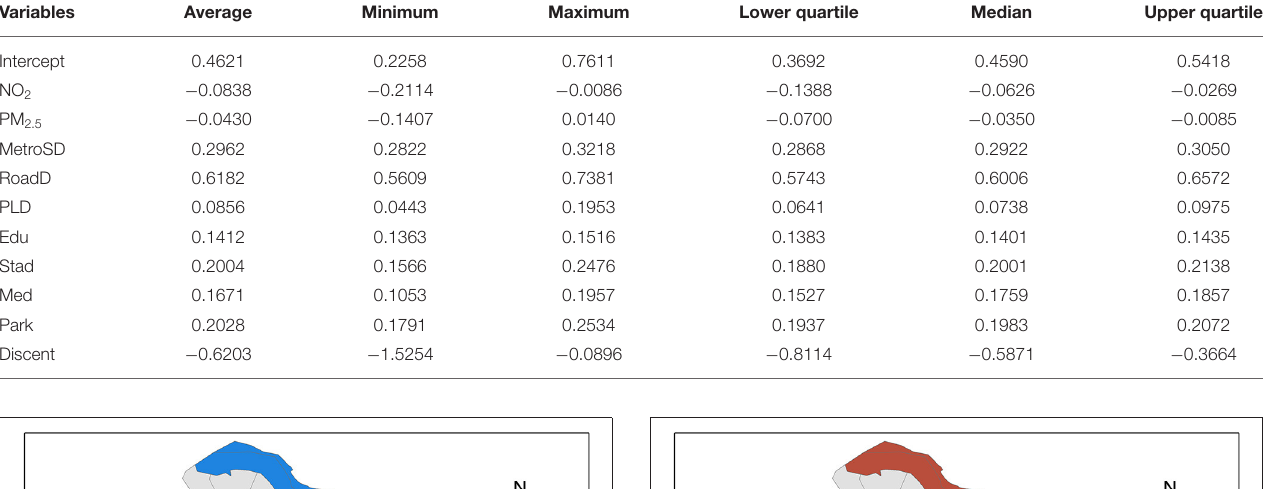
TABLE 6 | GWR modeling results (the coefficients of different variables).